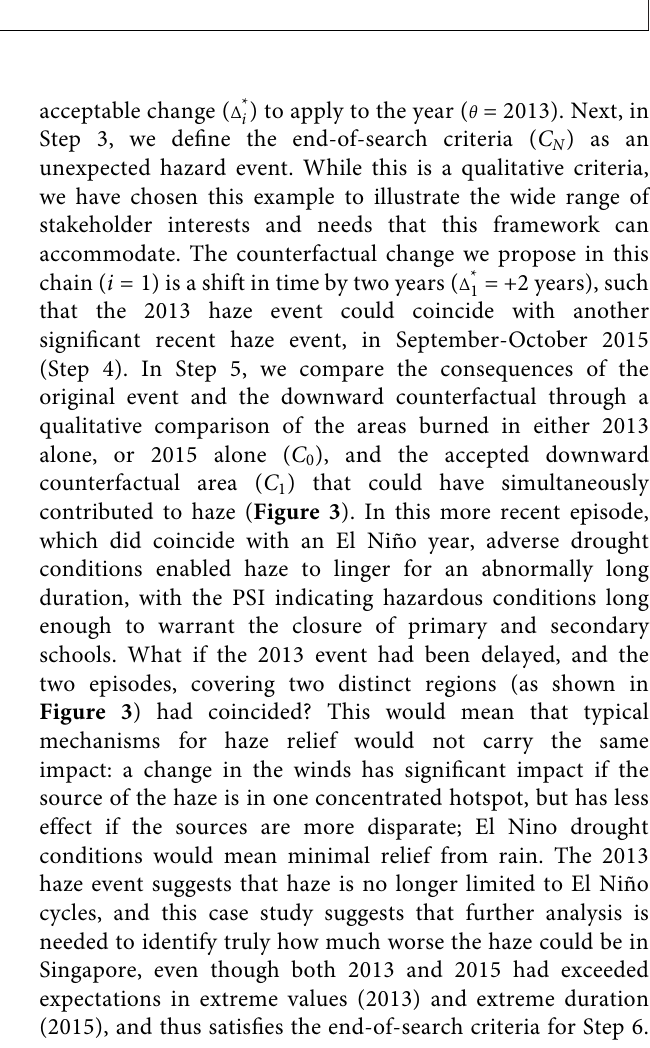
Frontiers in Earth Science |